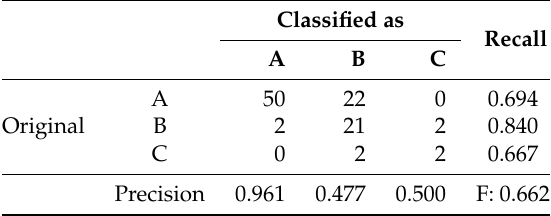
Table 13. Confusion matrix of linkage line visibility classification in online experiment. Classified as Recall A B C Original